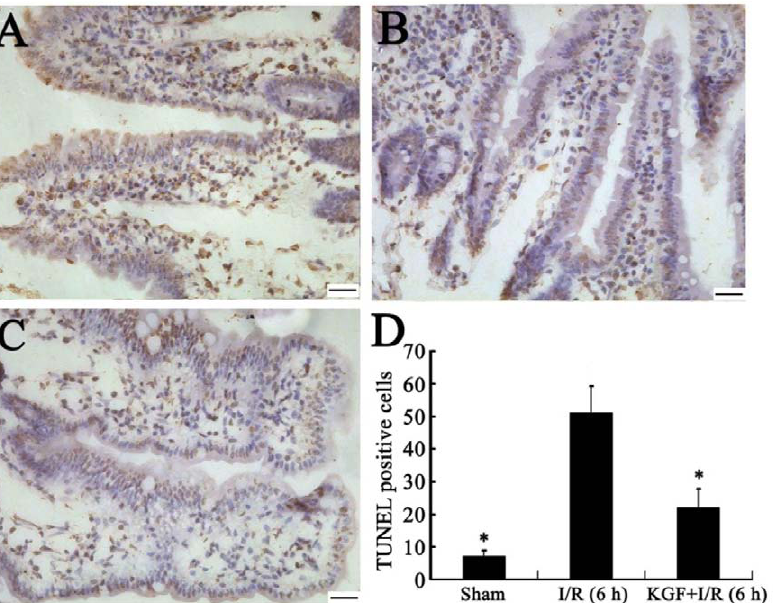
Figure 5. TUNEL staining of small intestine of mice after KGF treatment. The number of TUNEL positive cells was counted at a high magnification ( 6 400). The number of TUNEL positive cells was significantly increased in the I/R group after 6 h intestinal I/R (A), as compared to the sham group (B); KGF significantly prevented the increase in TUNEL positive cells in the I/R(6 h) + KGF group (C) when compared with the I/R (6 h) group; (D) The number TUNEL positive cells is presented as mean 6 SD. * P , 0.05 vs. I/R group, n=6 per group. Scale bar=25 m m.